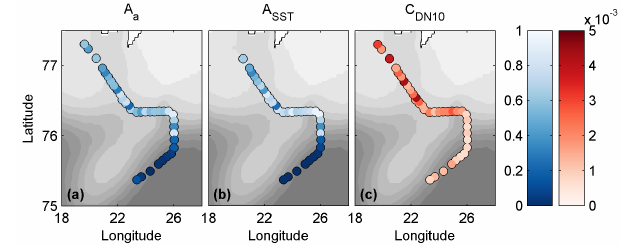
Figure 8. Spatial maps of ice fraction (a) A a , (b) A SST , and (c) drag coefficient C DN10 for all flux-runs during MASIN Flight 181, as Fig.